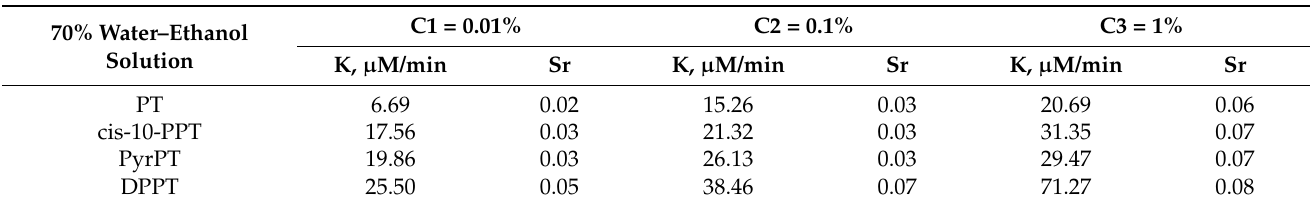
Table 5. Values of the antioxidant activity of phenothiazine and its derivatives in 70% water– ethanol solution.